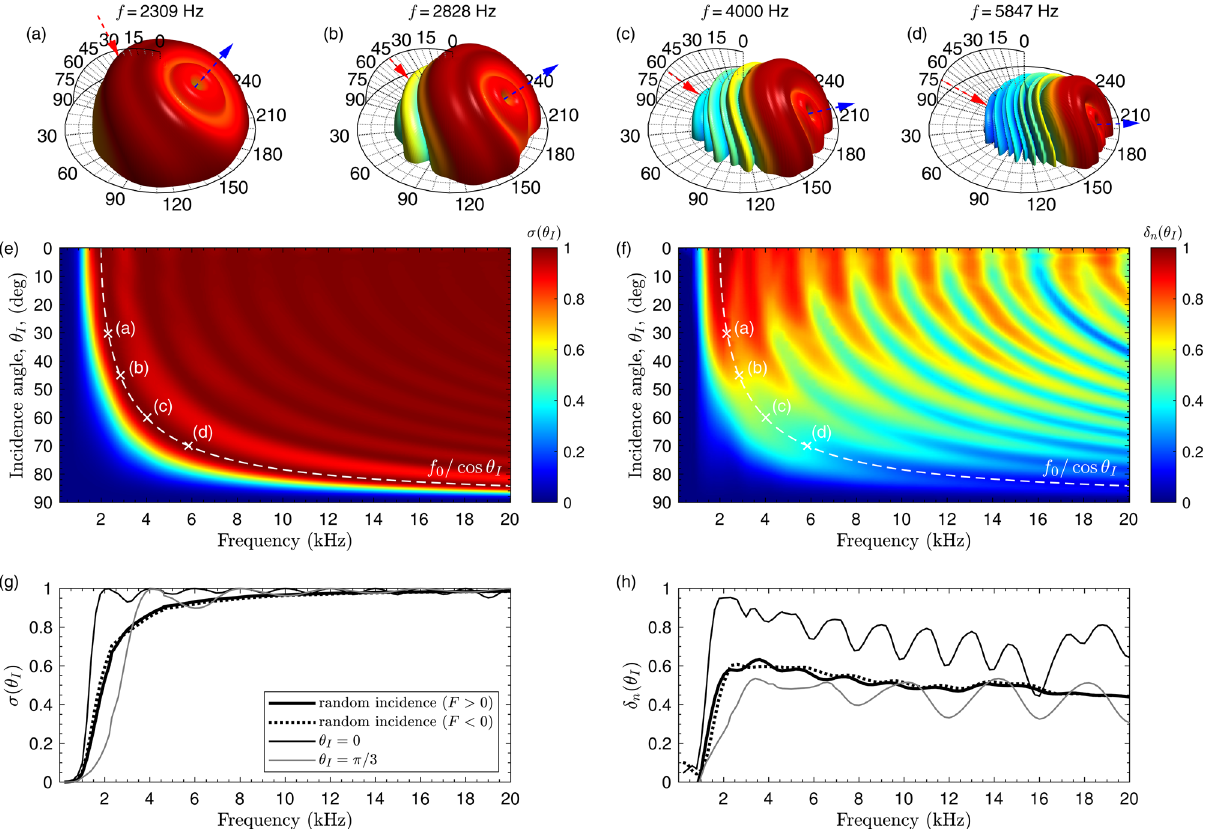
30 , 45 , 60 70 ◦ ◦ ◦ and ◦ at f = f 0 , and ( a2 – d2 ) at =